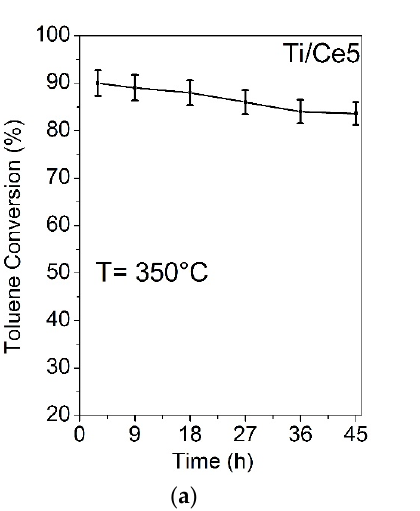
Figure 10. Photothermo-catalytic oxidation of toluene on the Ti/Ce5 composite: ( a ) the variation in the toluene conversion after a long-time on-stream test; and ( b ) the toluene conversion curves after 5 consecutive runs. 5 consecutive